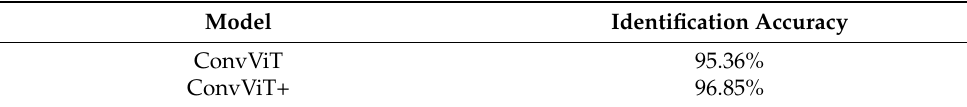
Table 6. Comparison test results of original patch embedding and overlapping patch embedding on apple diseases datasets. “ConvViT” stands for adopting original patch embedding, while “ConvViT+” stands for adopting overlapping patch embedding.